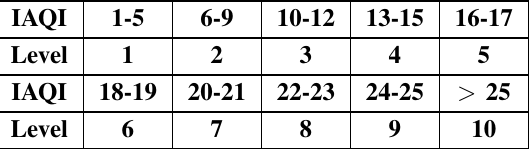
TABLE II P OLLUTION S PLITTING L EVELS FOR G ROUP O XIDE .